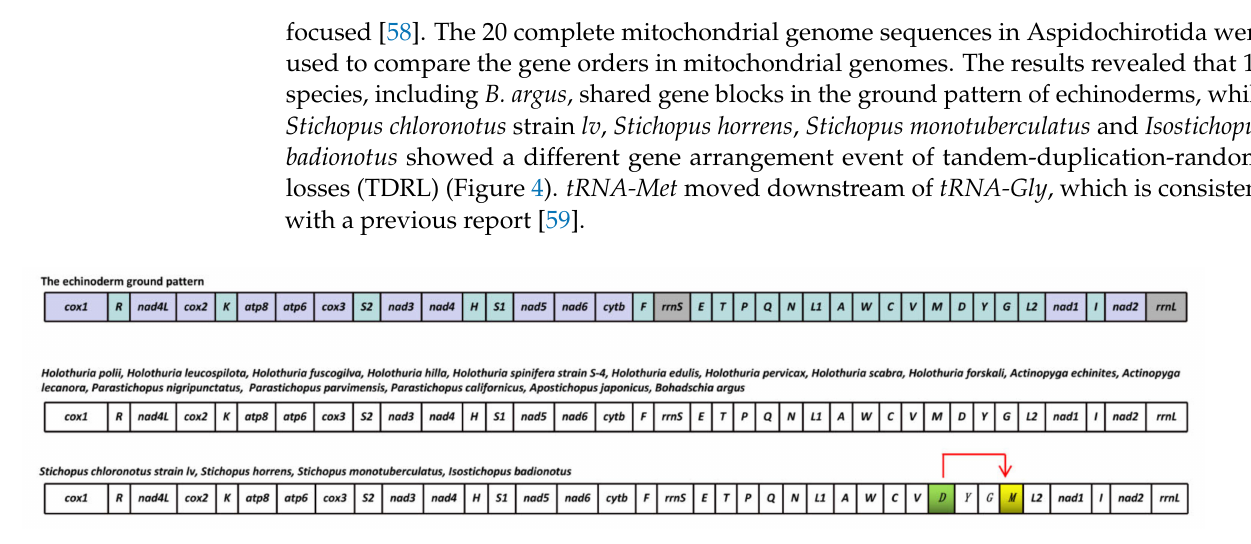
Figure 4. Linearized representation of the conserved mitochondrial gene order in 20 holothuroid species. A red arrow represents a gene arrangement event of tandem-duplication-random-losses (TDRL).